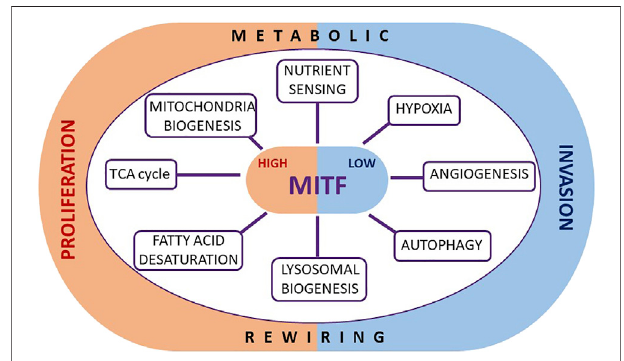
FIGURE 1 | Metabolic roles of MITF in melanoma. The transcription factor MITF, known to regulate melanoma plasticity and cell identity, may play such a role also through the direct regulation of speci fi c genes crucially involved in several metabolic functions. By modulating metabolic events such as the TCA cycle, mitochondrial biogenesis, nutrient sensing, the hypoxia response, angiogenesis, autophagy, lysosome biogenesis and fatty acid desaturation, MITF tunes cell proliferation, and prevents the stabilization of an invasive phenotype.